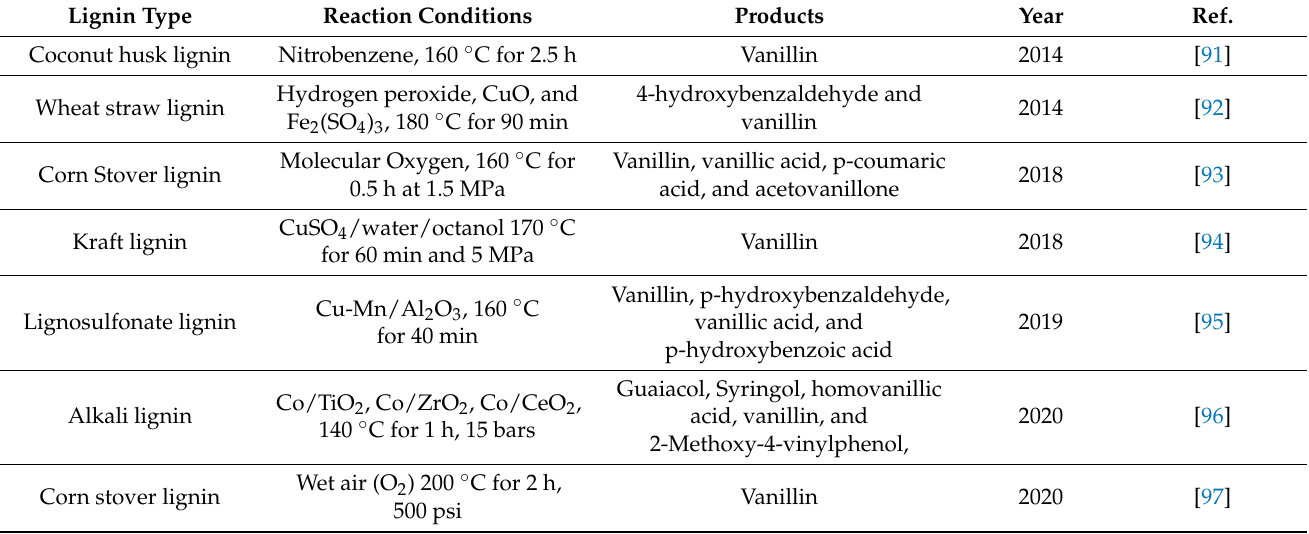
Table 4. Oxidative depolymerization of